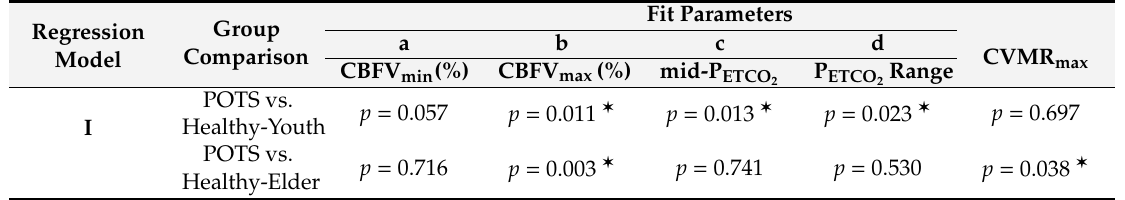
Table 5. Statistical results of average fit parameters between groups for fitting Models I and II.